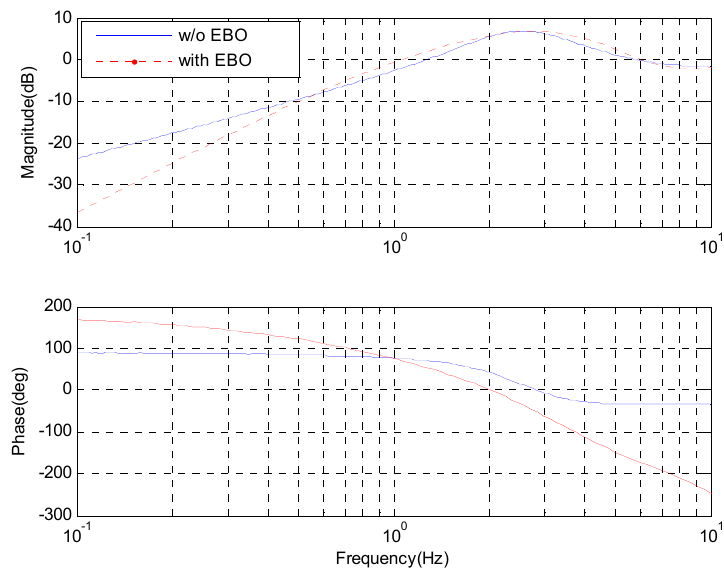
Figure 8. The experimental error attenuation.